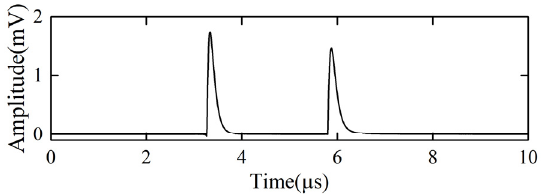
Figure 5. The time domain waveform of the simulated PD pulse for the defect at d = 250 m.